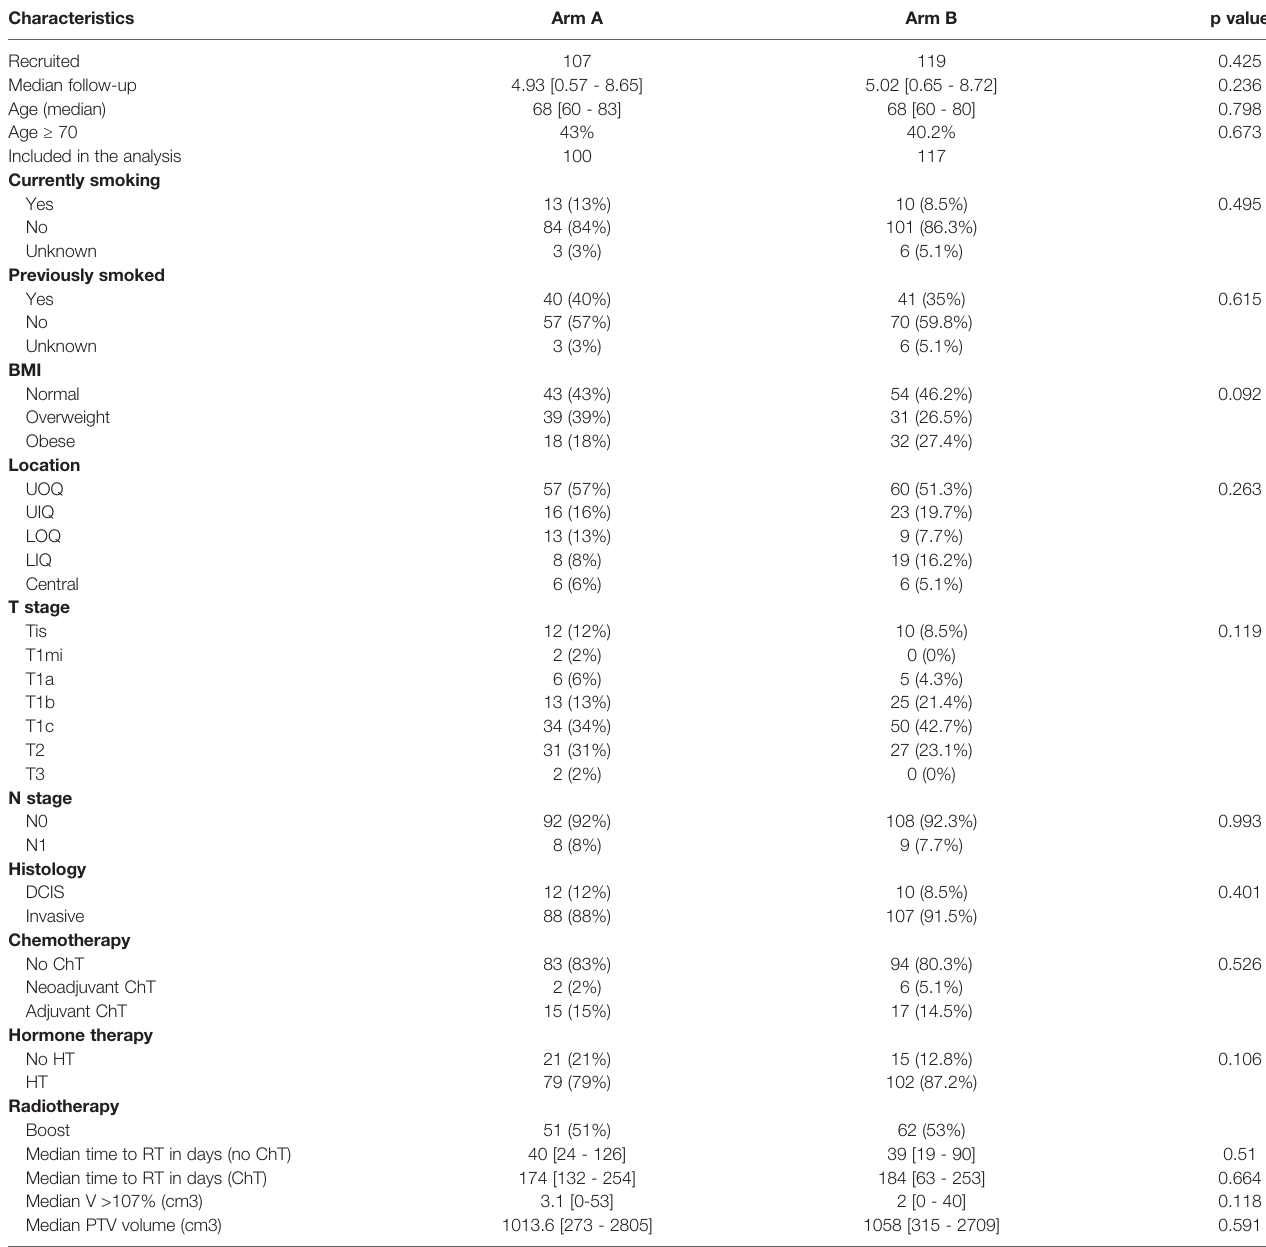
TABLE 1 | Baseline cohort